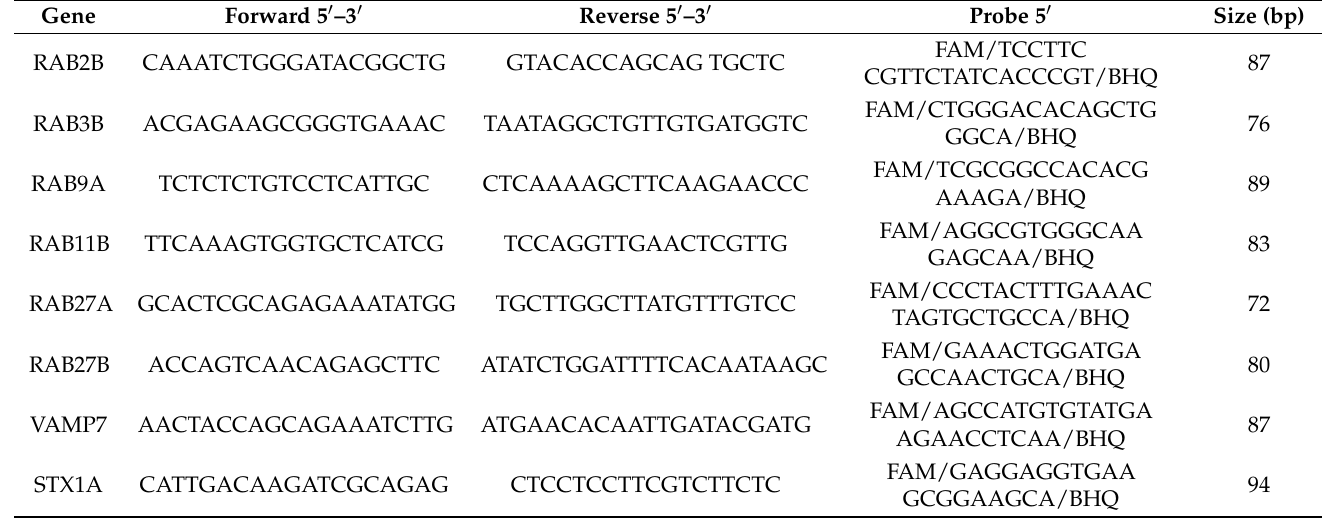
Table 2. The list of primers and probes used for gene expression analysis by quantitative Real Time